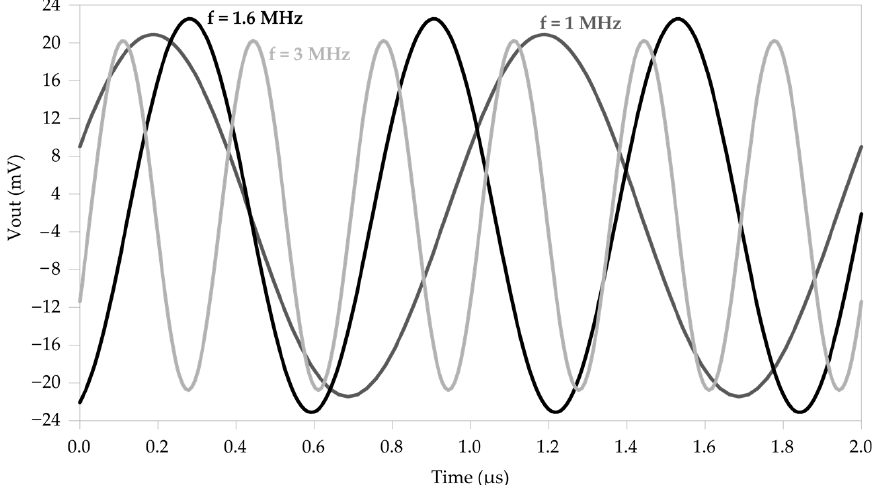
Table 3. Comparison between the proposed circuit and other reported works.